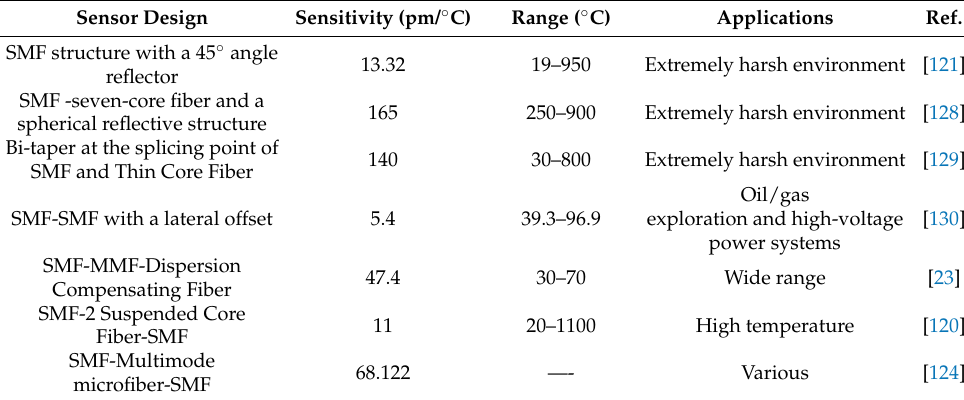
Table 8. Temperature sensitivity of FOMI.